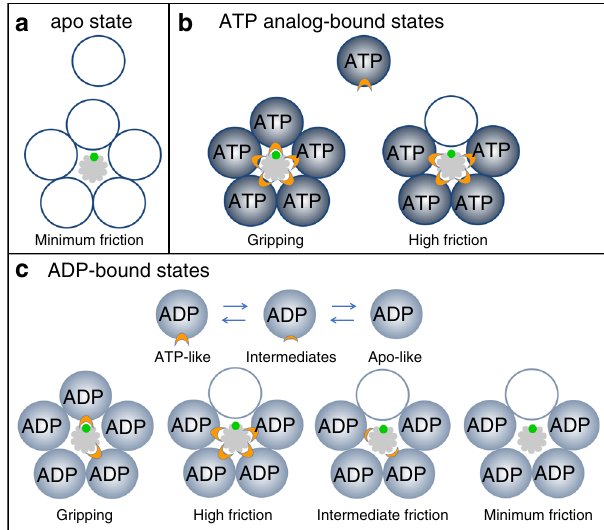
Fig. 4 Model for motor-DNA interactions. a In the apo state motor subunits (depicted as fi ve empty circles) do not grip the DNA (gray). They exert only minimal friction, and the DNA slips rapidly. b With the ATP analog bound the subunits (blue circles; the label “ ATP ” refers to the analog γ -S-ATP) are in a gripping-capable conformation, but only one subunit is optimally aligned to form a grip, consistent with structural data 20 . If the γ -S-ATP dissociates the grip is released, but the other subunits still have γ -S-ATP bound and are in strong frictional contact, resulting in very slow slipping. The region of the motor protein that grips the DNA is schematically indicated by the orange “ gripper ” and the region of the DNA structure that is gripped is schematically indicated as a green “ patch ” . Speci fi c regions involved have been proposed based on structural studies 20, 21, 51 . c With ADP bound the motor subunits (labeled circles) fl uctuate between a gripping/high friction conformation similar to the ATP-bound state, intermediate-friction conformations (schematically indicated by smaller orange “ grippers ” ), and a minimum friction state similar to the apo state. If ADP dissociates from a gripping subunit the grip is released, but the other subunits exert friction on the DNA. The amount of friction can vary widely depending on how many subunits are in ATP-like, intermediate, or